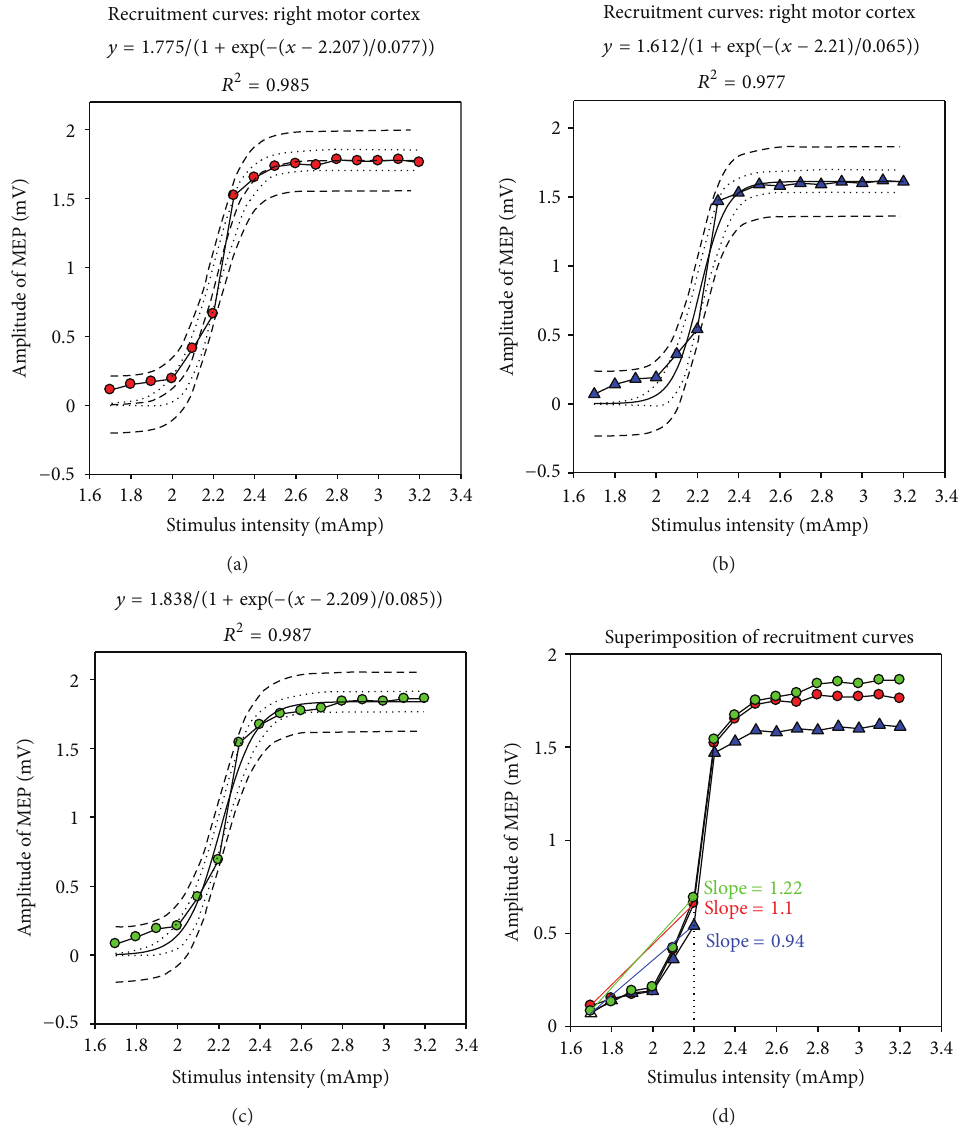
Figure 1: Examples of recruitment curves of corticomotor evoked responses (MEP: motor evoked responses) following incremental electrical stimulation of the right motor cortex for one rat. Recordings in left gastrocnemius muscle. (a) Recordings at baseline. (b) Recordings following application of anodal direct current stimulation over left cerebellar hemisphere. (c) Recordings following stimulation of left cerebellar hemisphere with cathodal direct current stimulation. (d) Superimposition of the 3 recruitment curves. Individual values are shown with red circles in (a), blue triangles in (b), and green circles in (c). Sigmoidal fitting (3 parameters: 𝑦 = 𝑎/[1 + exp (−(𝑥 − 𝑥 0 )/𝑏)] ); 95% prediction bands (dash) and 95% confidence bands (dotted) are shown in (a), (b), and (c). In (d), the slope from the first to the sixth point is smaller following anodal stimulation: 0.94 as compared to 1.1 at baseline and 1.22 after cathodal stimulation. Stimulation intensity is increased by steps of 0.1mAmp following determination of the motor threshold on each side. Amplitudes are expressed in